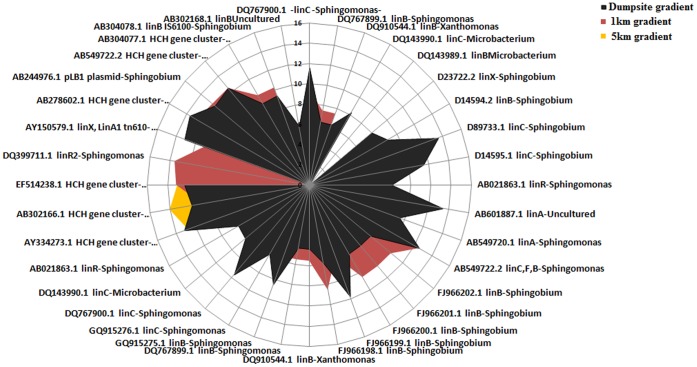
DNA-seq analysis of the community potential for HCH degradation.DNA-seq analysis of metagenome sequences against reference lin genes using Array star, x axis represents the relative abundance of lin genes from different genera (Table S8) present at studied metagenomes.